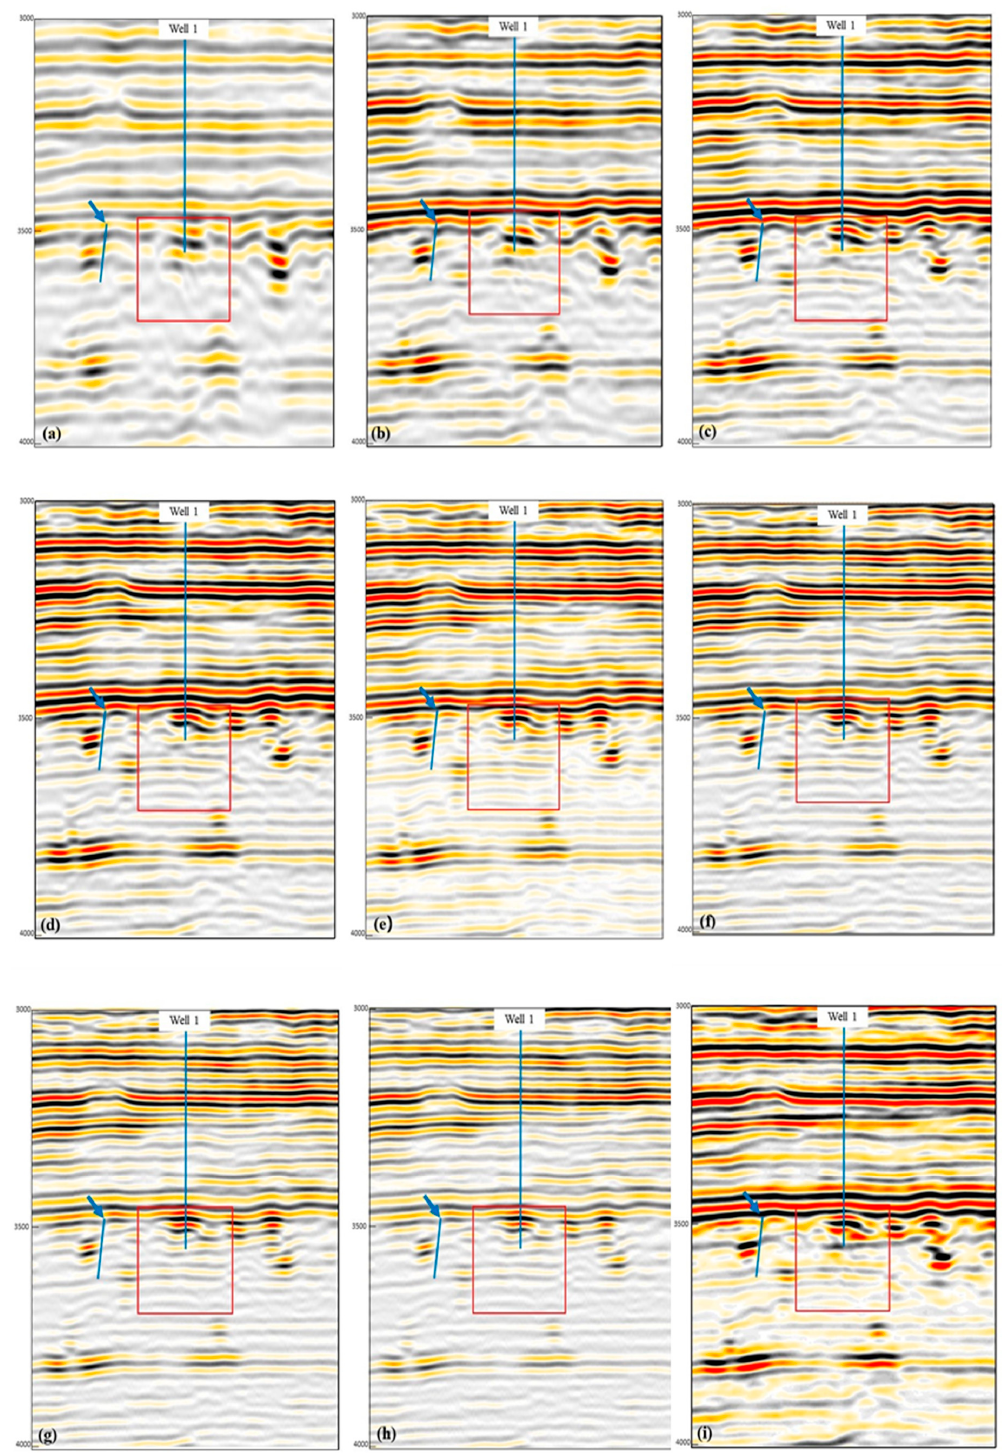
Figure 5. Seismic sections of different single-frequency data around Well 1. ( a )–( d ) represent 15 Hz, 20 Hz, 25 Hz, and 30 Hz, respectively. ( e ) represents 35 Hz. ( f )–( h ) represent 40 Hz, 45 Hz, 50 Hz, and 55 Hz, respectively. ( i ) represents the original full-band seismic